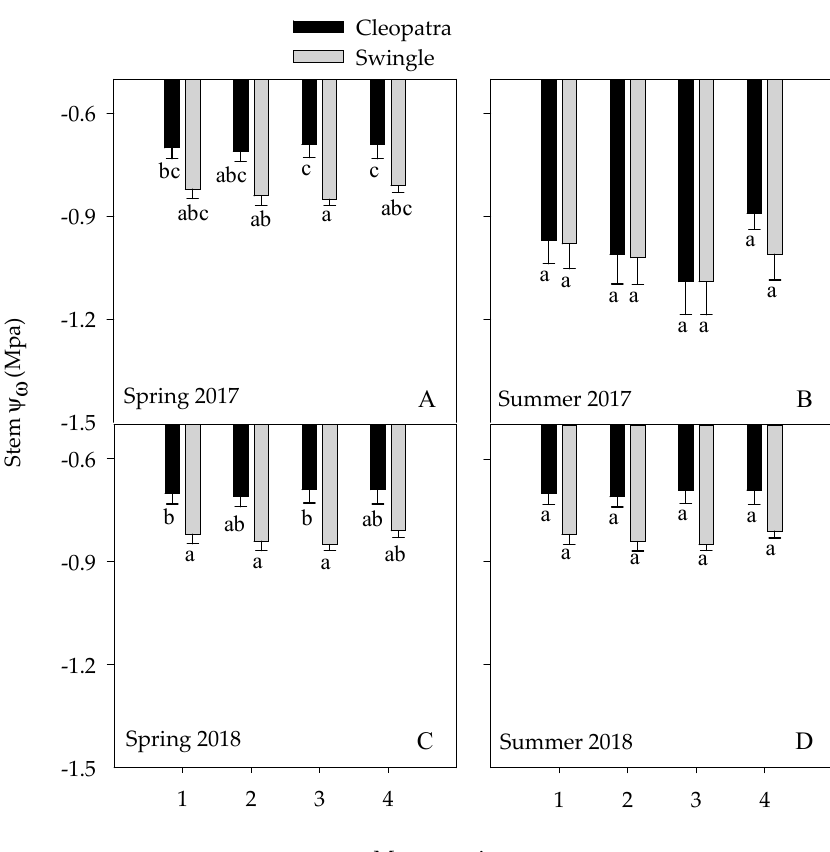
Figure 1. Stem water potential ( Ψ w ) of Huanglongbing (HLB)-affected Hamlin citrus trees in spring ( A , C ) 2017 and summer ( B , D ) 2018 seasons. Treatments (T): Control (1), full Ca dose (2), full Mg dose (3), and half Ca and half Mg doses (4), (full dose = 45 kg ha − 1 ). Means followed by different lower case letters are significantly different at p ≤ 0.05, based on the Tukey–Kramer honestly significant difference test (n = 36) [1 MPa = 10 bar, 1 g m –2 = 0.0033 oz/ft 2 ].